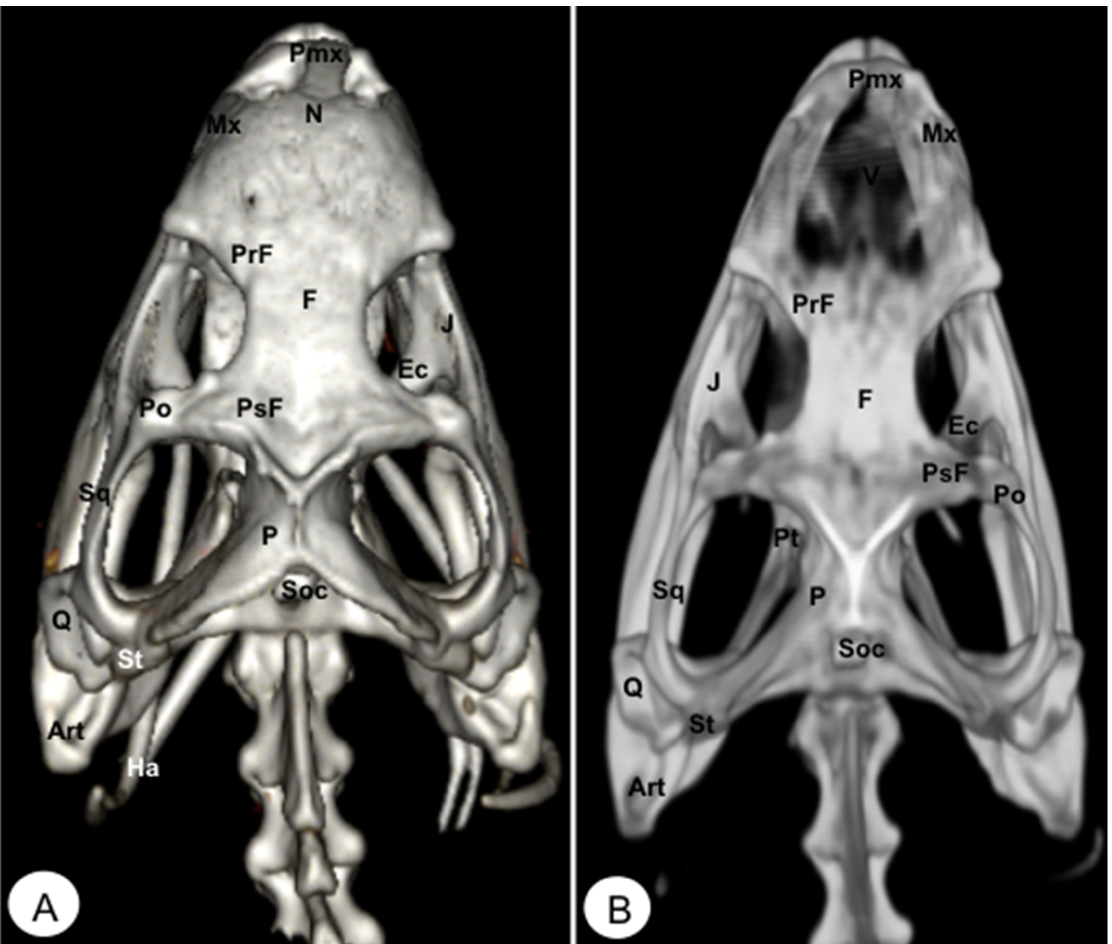
Figure 10. Head of Iguana iguana . ( A ) Dorsal VR view. ( B ) Dorsal MIP view. Pmx: Premaxillary bone. Mx: Maxilla. N: Nasal. PrF: Prefrontal. F: Frontal. PsF: Postfrontal. Po: Postorbital. J: Jugal. Pt: Pterygoid. Ec: Ectopterygoid. Q: Quadrate. Sq: Squamousal. St: Supratemporal. P: Parietal. Soc: Supraoccipital. Art: Articular. Ha: Hyoid apparatus.